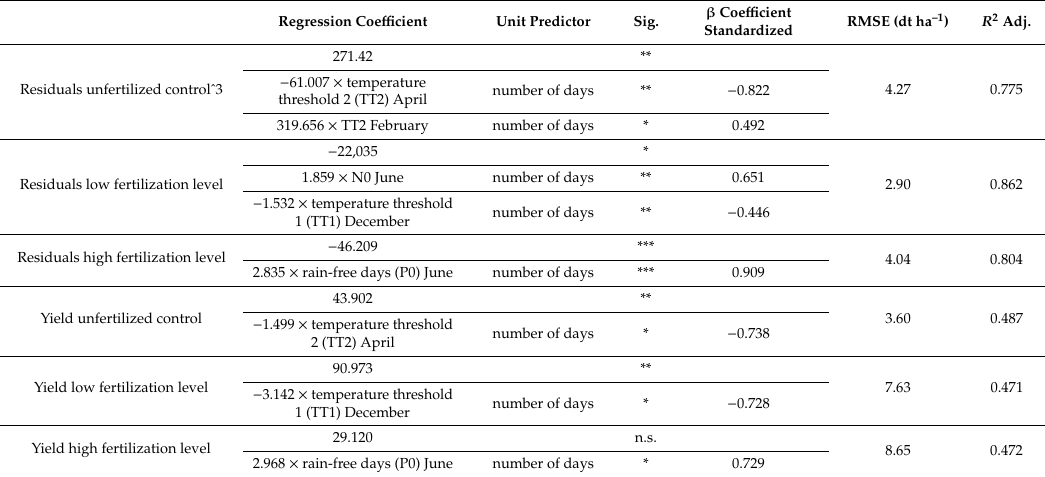
Table 6. Formulas depicting multiple linear regressions derivation of residuals and yields for di ff erent levels of fertilization with monthly climate